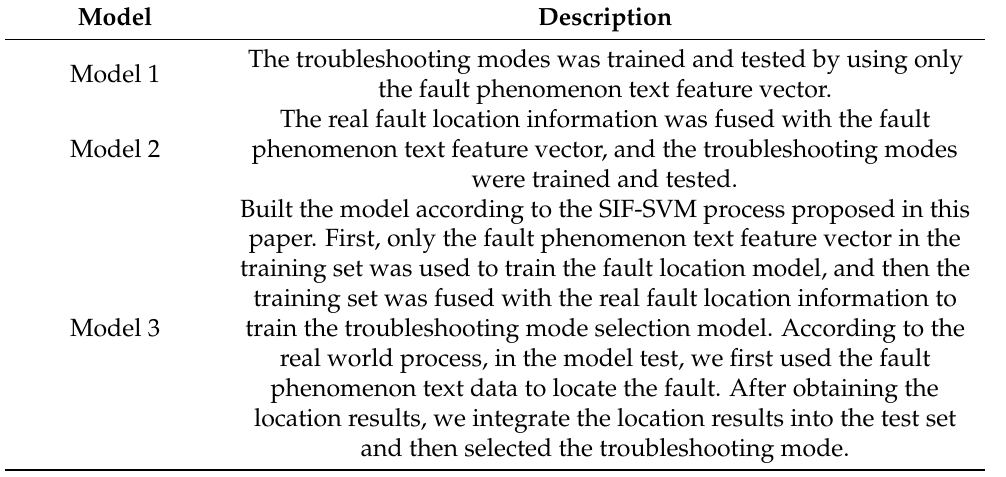
Table 7. Description of models